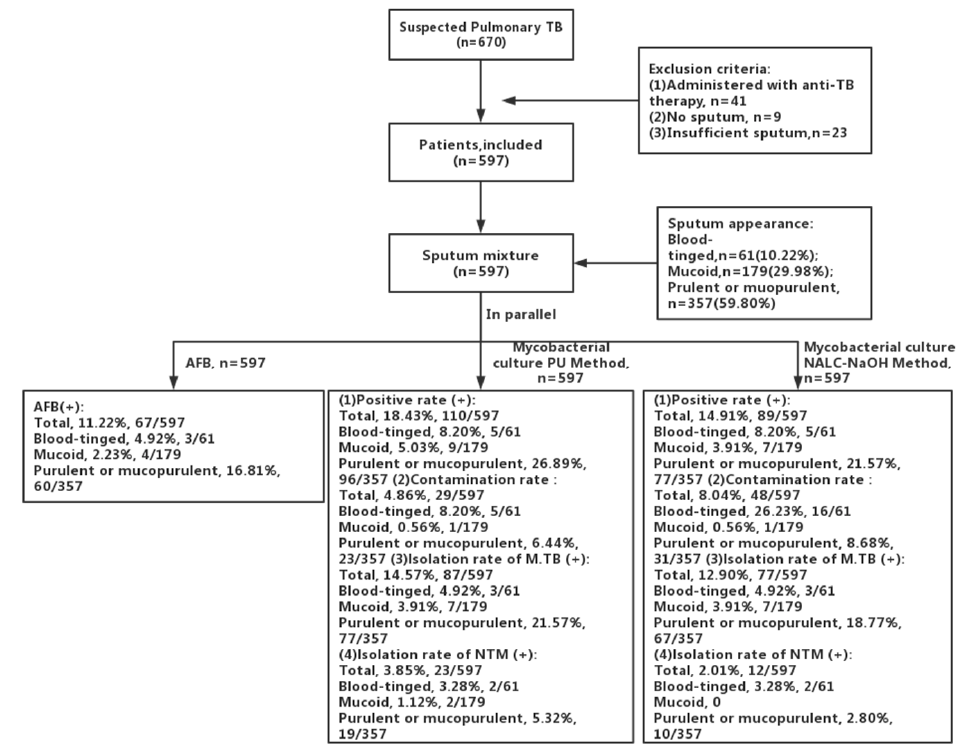
Figure 1. Patient Figure 1. Patient selection.